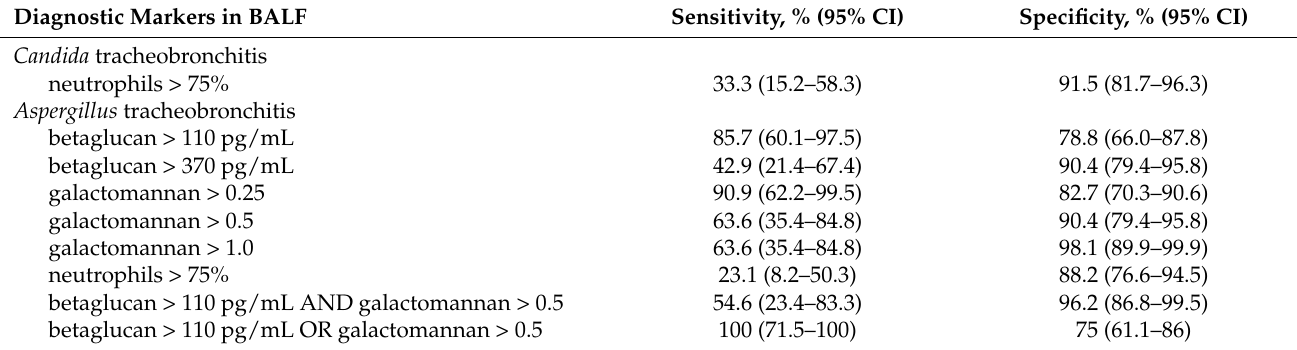
Table 3. Sensitivity and specificity of diagnostic markers for the diagnosis of Candida and Aspergillus tracheobronchitis. Controls consist of patients with Candida and Aspergillus colonization or patients with no evidence of fungi in BALF,